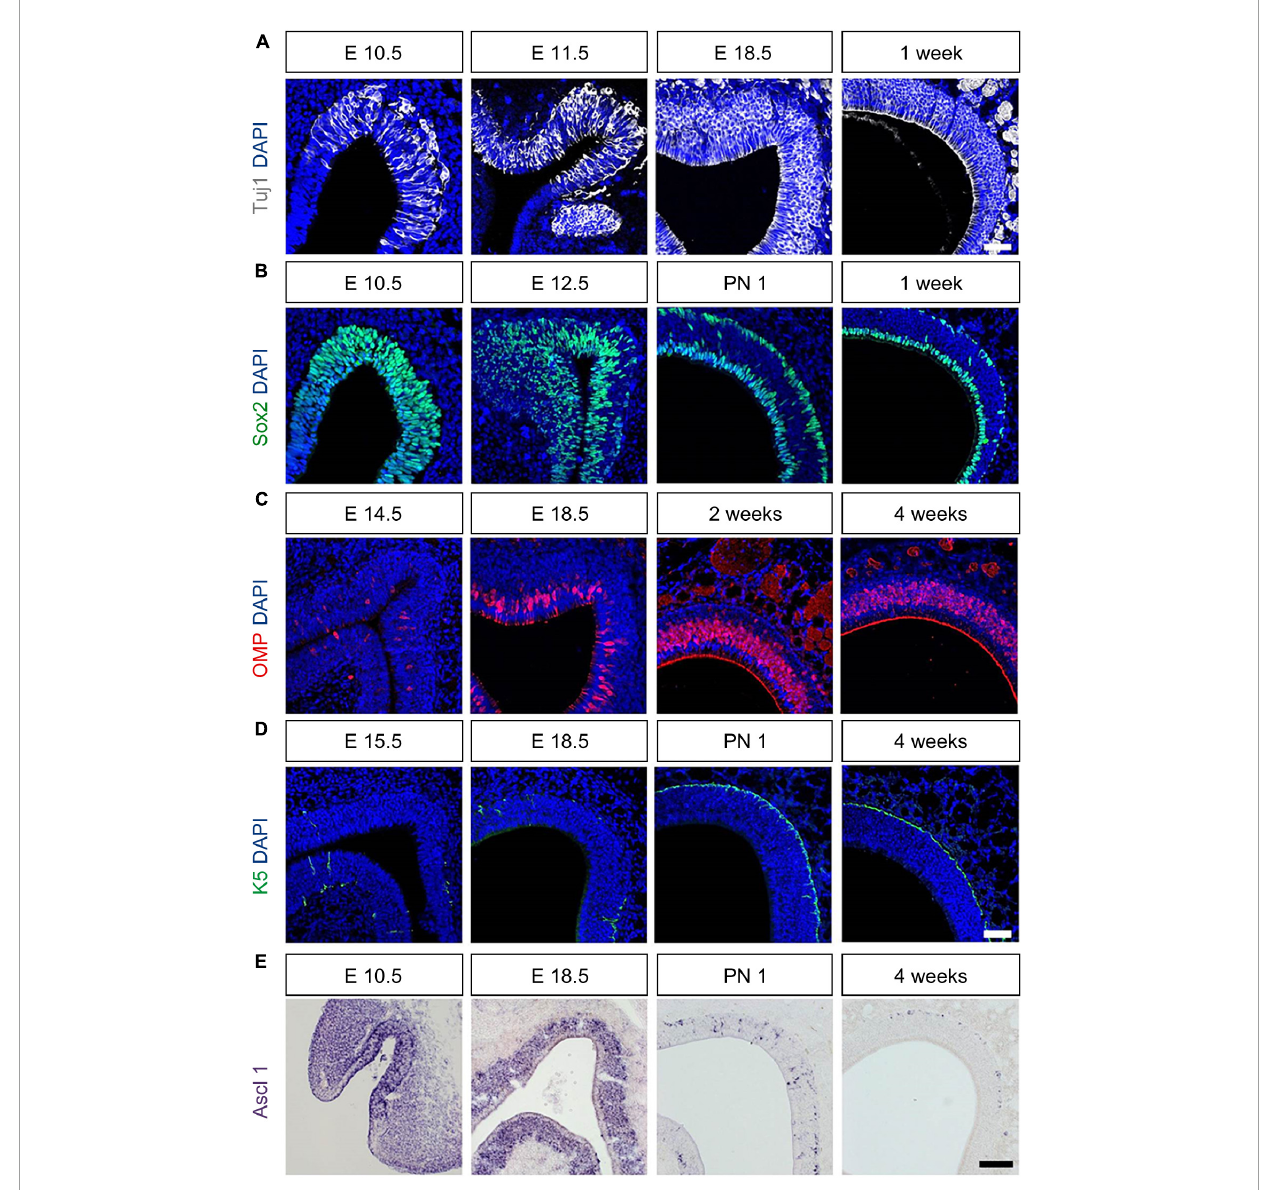
FIGURE2 Molecular and cellular changes during the development of OE. All images were obtained in the coronal direction. (A) Immunostaining with an anti-Tuj1 antibody and DAPI at E1.5, E11.5, E18.5, and 1 week. (B) Immunostaining with an anti-Sox2 antibody and DAPI at E10.5, E12.5, E18.5, PN 1, and 1 week. (C) Immunostaining with anti-OMP antibody and DAPI at E14.5, E18.5, 2, and 4 weeks. (D) Immunostaining with an anti-K5 antibody and DAPI at E13.5, E18.5, PN 1, and 1 week. (E) In situ hybridization with an anti-Ascl probe at E10.5, E14.5, 2- and 4 weeks. Scale bar, 50 µ